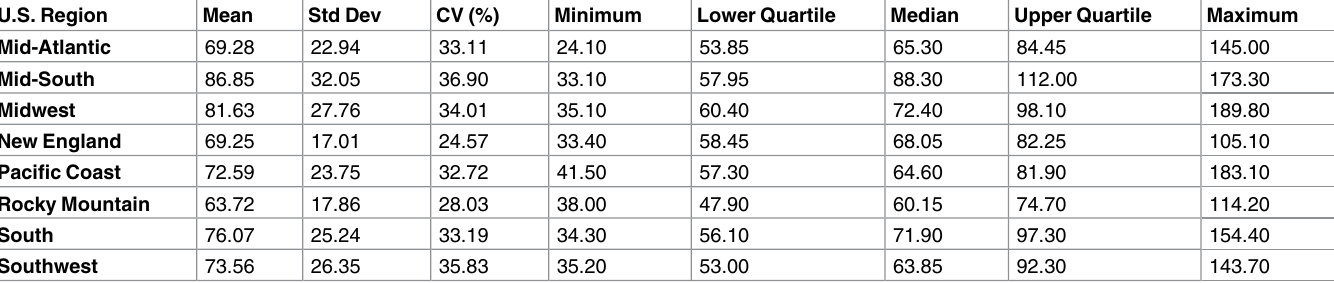
Table 6. Summary statistics of lung cancer incidence rates for Whites in 8 U.S. geographic regions, 1999–2012 (cases per 100,000). U.S.